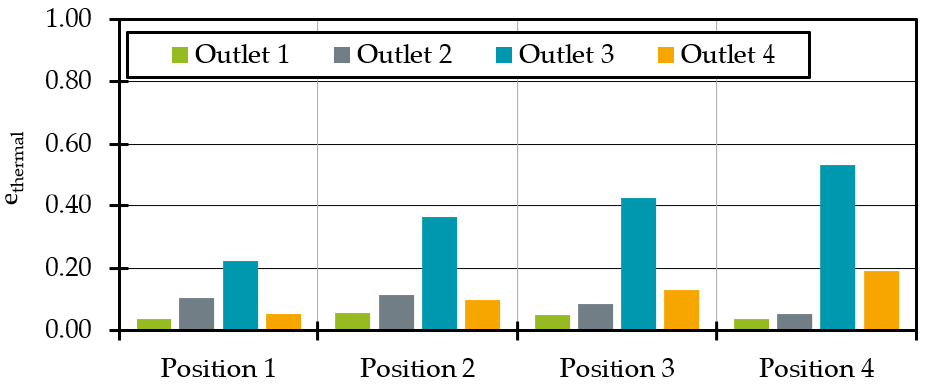
Figure 11. Thermal homogenisation indicator e thermal at each outlet for different heat pipe positions.